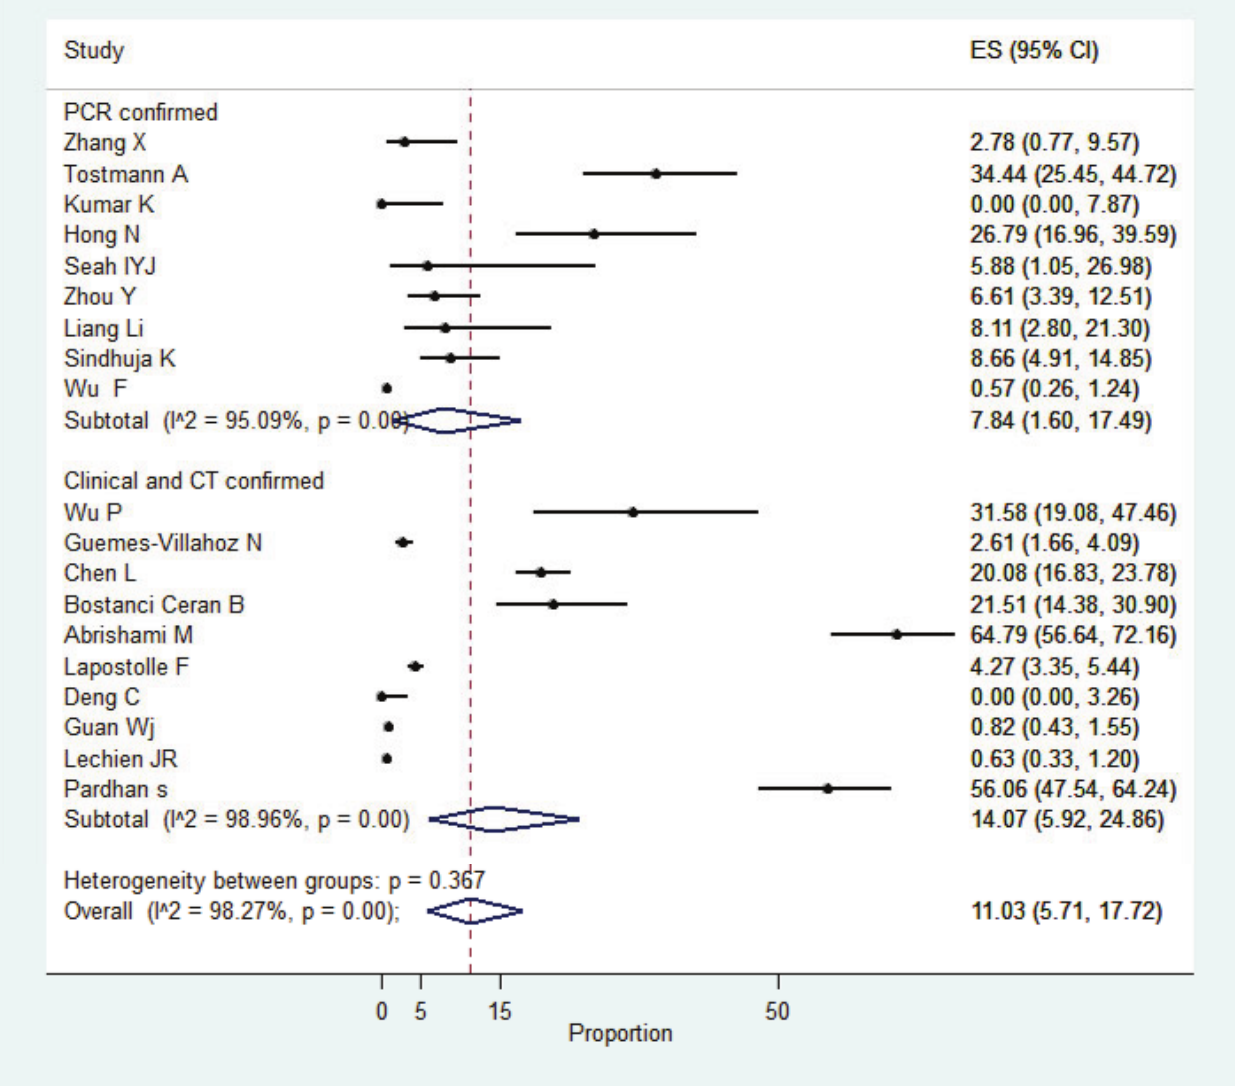
Figure 2. Pooled prevalence of ocular manifestation among patients with